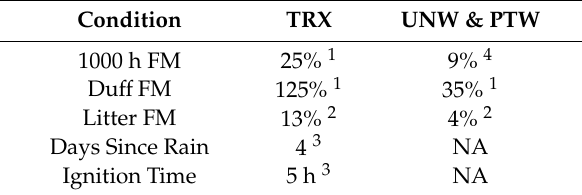
Table 4. Inputs used to populate the Fuel and Fire Tool [29] runs for each scenario. Condition